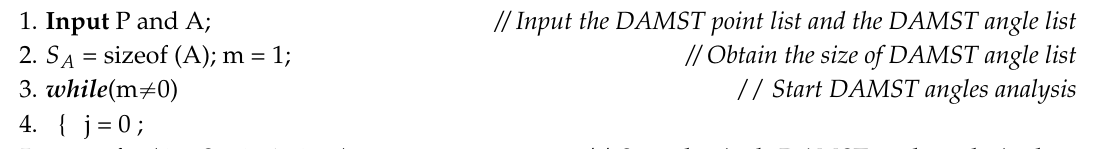
Algorithm 1. The Damst angle analysis